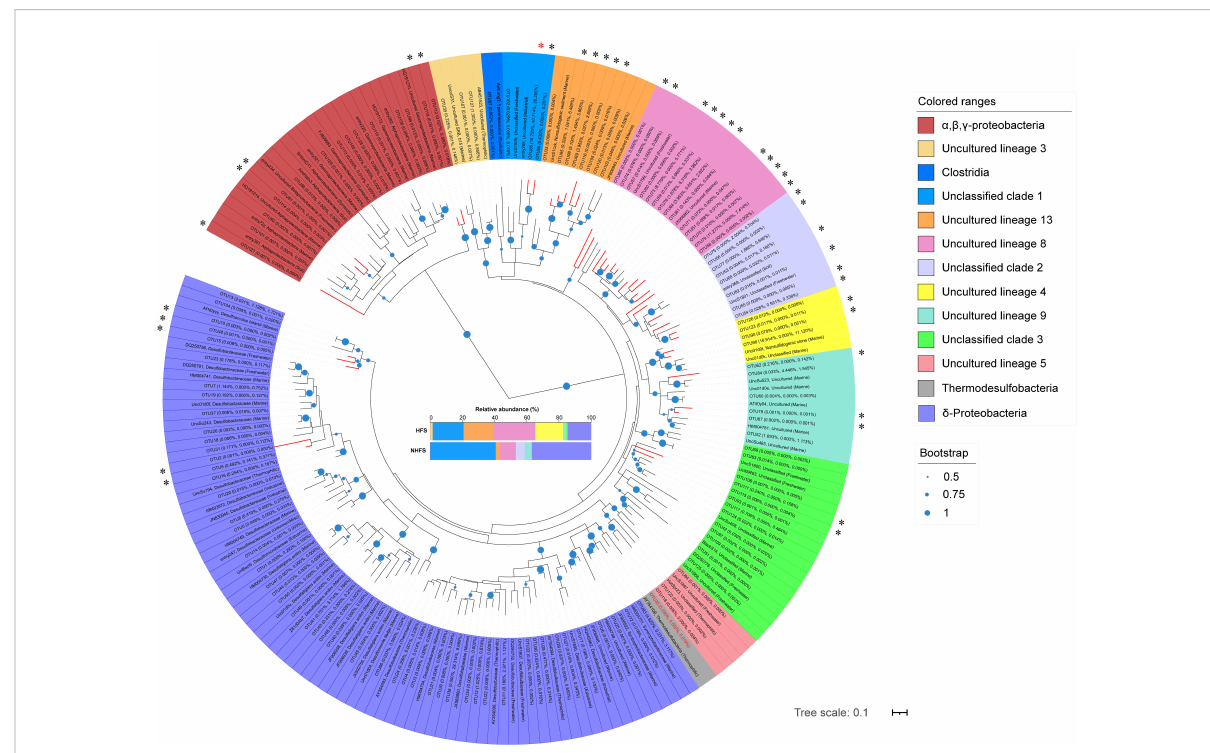
FIGURE 7 Maximum-likelihood phylogenetic tree of the representative bacterial dsrB sequences in this study and the relevant sequences retrieved from the reference (Müller et al., 2015). The average relative abundances of OTUs in the HFS, NHFS, and total samples are shown at the fi rst, second, and third positions in the parentheses, respectively. The source habitats of the reference sequences are also given in the parentheses. Colors represent different microbial classes. The compositions of these classes in HFSs and NHFSs are shown in the middle of the fi gure. Bootstrap values higher than 50% of 1,000 resamples are shown by dots of different sizes at branch points. Scale bar represents 0.1 nucleotides substitution per site. Branches of potential novel dsrB genes are shown in red, and corresponding OTUs are marked with “ * ” , with the most abundant “ OTU86 ” marked in red. The sequence name of “ OTU35 ” is in